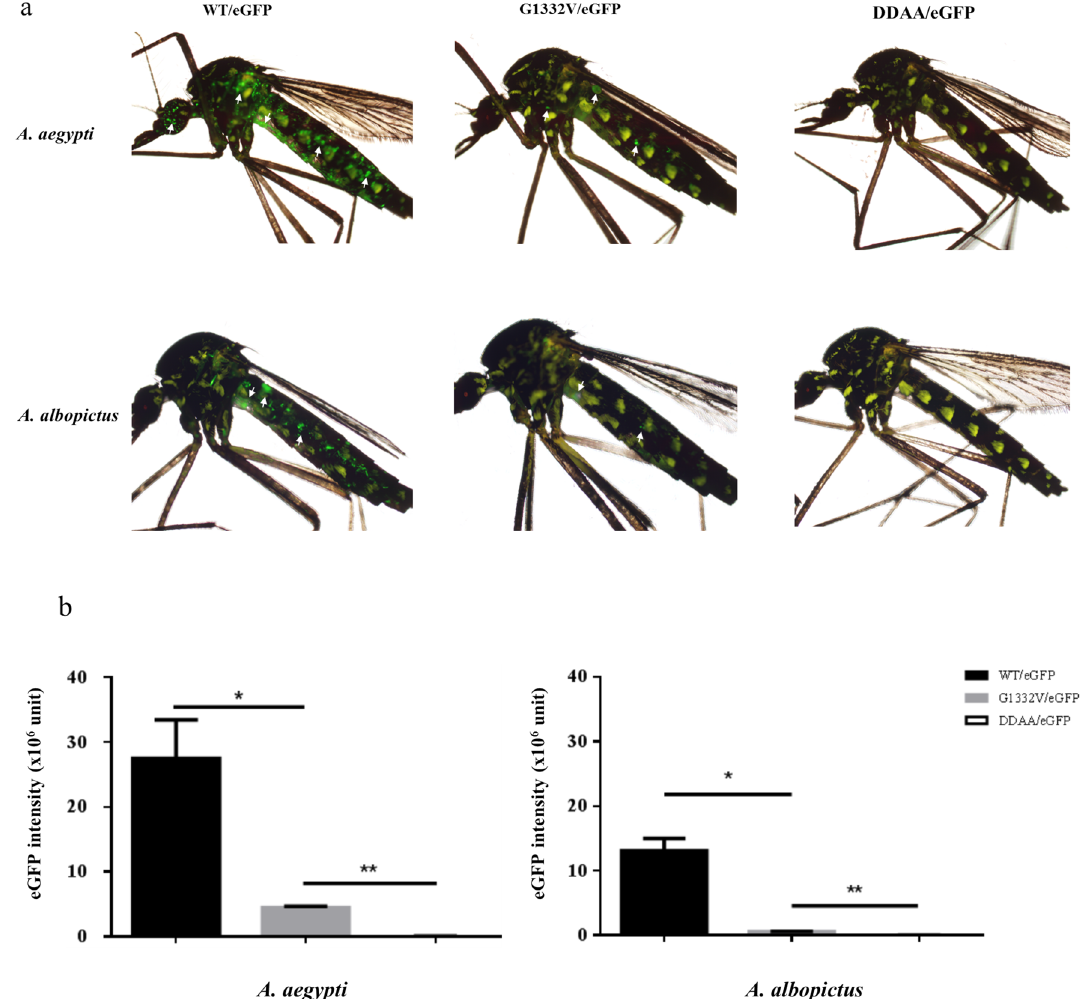
Figure 10. In vivo functional analysis of CHIKV replicon variants in mosquitoes. Adults of A. aegypti (upper panels) and A. albopictus (lower panels) were intrathoracically injected with either WT/eGFP (left panels), G1332V/eGFP (middle panels), or DDAA/eGFP (right panels) at a dose of 5 × 10 6 pfu/mosquito. The eGFP expression (indicated by white arrows) was photographed ( a ) and quantified ( b ). Statistical significance was analyzed using Student’s t-test (* p < 0.05 and ** p <